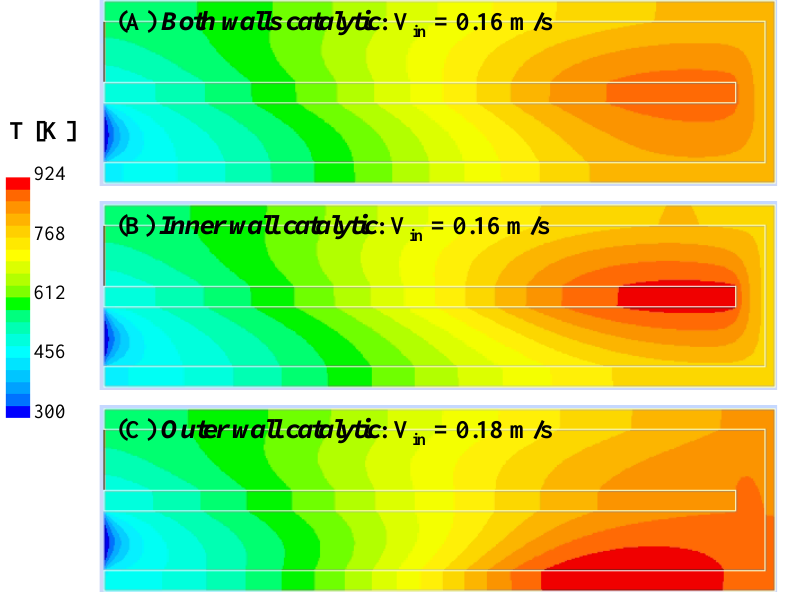
Figure 5. Contours of temperature at extinction for the three reactor configurations of Figure 1 with different catalyst placement. Low thermal conductivity (3 W/(m K)). The computational domain is scaled along the transverse direction by a factor of 2.